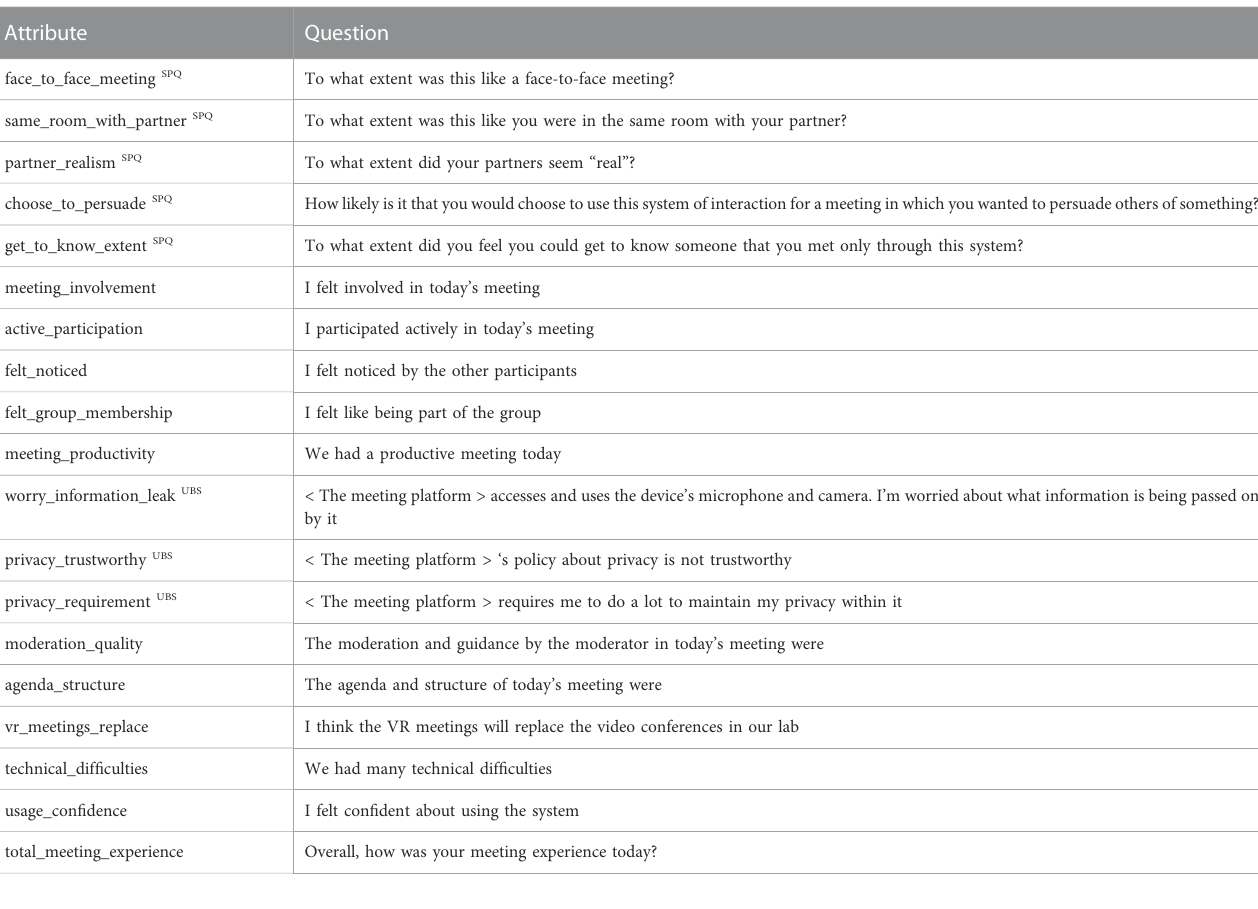
TABLE2Overviewofthemostimportantquestionnaireitems.Questionsfromstandardizedinstrumentsaredenotedwith SPQ fortheSocialPresenceQuestionnaireby Nowak and Biocca. (2003) or UBS for the User Burden Scale by Suh et al. (2016). The constellations of all fi ve questionnaires is detailed in the supplemental material. Attribute